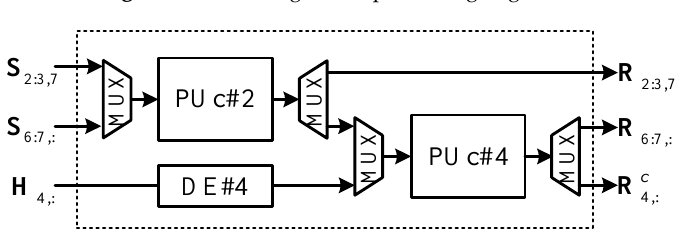
Figure 6. Block diagram of processing engine#2.